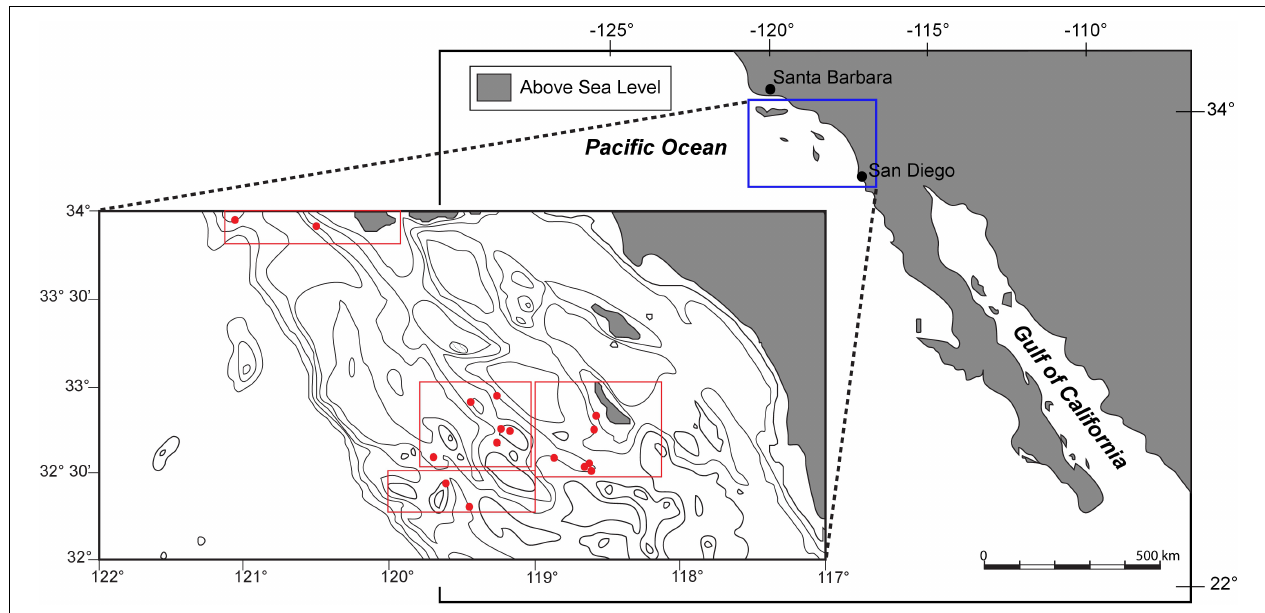
FIGURE 1 | Map and bathymetric chart of the study area within the Southern California Bight. Multicore locations, labeled with red filled circles, are described in detail with depth and environmental parameters in table one.